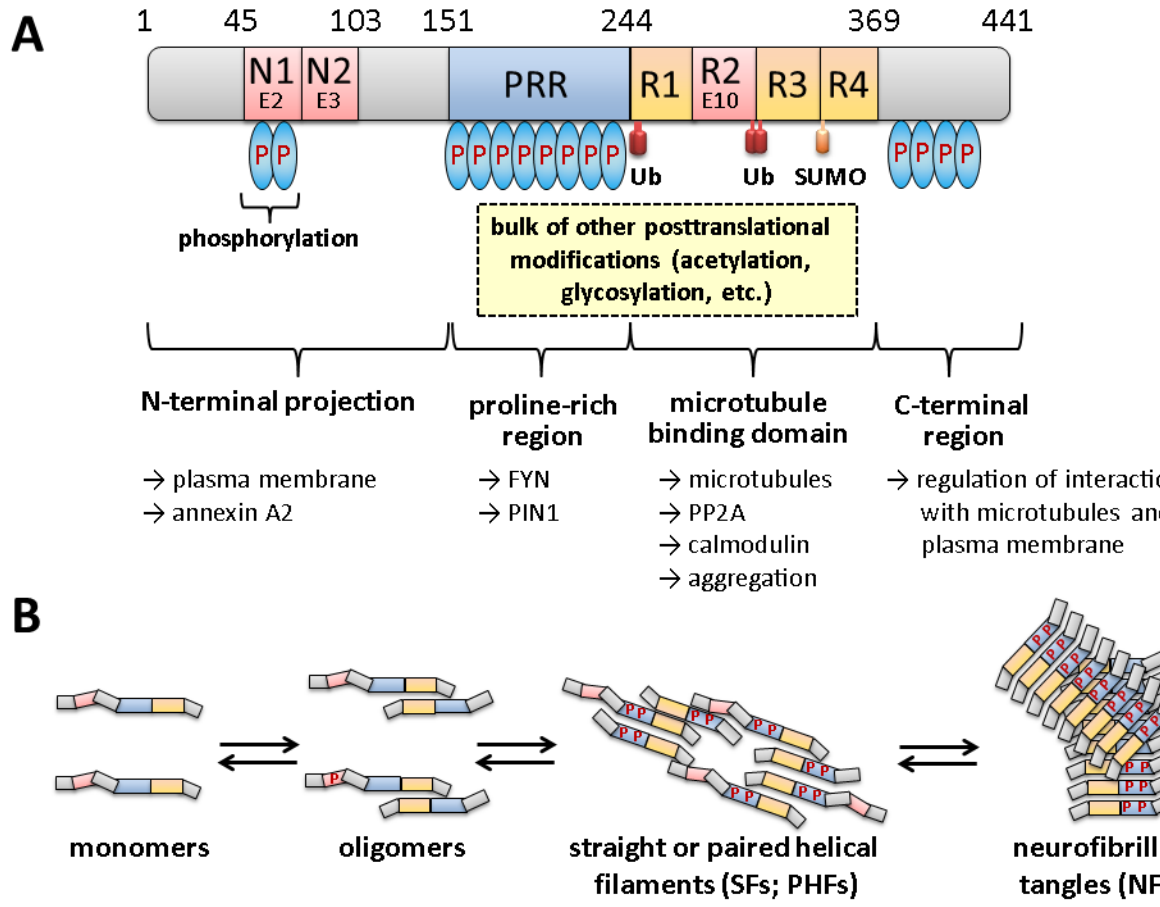
FIGURE 1: Domain structure and oligomerization of tau. (A) The longest isoform of human tau present in neurons of the central nervous system (CNS) is shown, which differs from other CNS isoforms in the presence or absence of two N-terminal domains (encoded by exons E2 and E3) and one of the repeats in the microtubule interaction domain (R2 encoded by exon E10). For variations in numbering and nomencla- ture consult [8]. Modifications by ubiquitination (Ub) and SUMOylation (SUMO) are indicated below. Not all phosphorylation sites (P in blue ovals) are shown, but the relative degrees are indicated by the number of ovals. Most of the other covalent modifications take place within the proline-rich region (PRR) and the R1-R4 motif. Some of the cellular structures and proteins for which interaction of the respective domains has been suggested are designated by the arrows shown below. This scheme summarizes informations from several excellent reviews, from which more detailed descriptions of the different modifications and their effect on tau in addition to those mentioned in the text can be ob- tained: [8, 9, 10, 11, 12]. (B) Different oligomerization states of tau are shown. It is believed that the monomeric form fulfills the physiological functions, while soluble oligomers and/or PHFs are responsible for the neurotoxic effects. As indicated, the formation of oligomers is